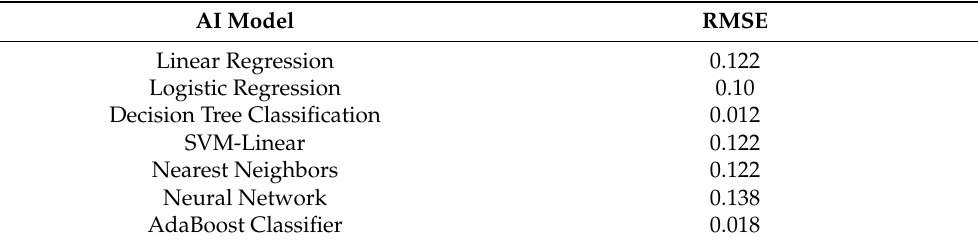
Table 4. Root mean square (RMSE) error for AI models trained with real